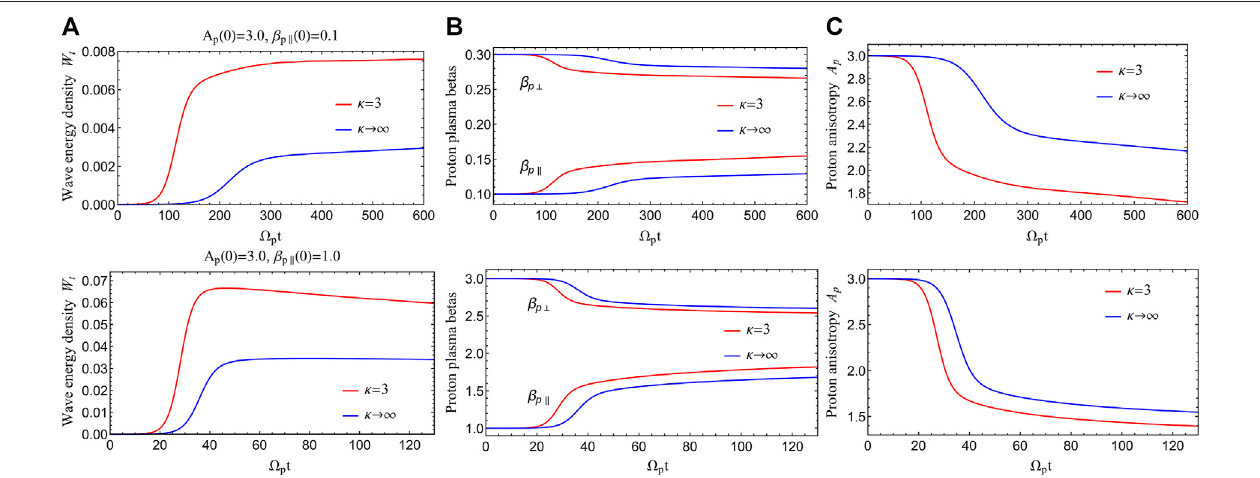
FIGURE6| QLevolutionoftheEMICinstabilityforbi-Kappa (red) and bi-Maxwellianprotons: magnetic energy (A) ,componentsofprotonplasmabeta (B) and the subsequent relaxation of the anisotropy (C) , obtained for A p ( t (cid:1) 0) (cid:1) 3.0 and β p (cid:3) ( t (cid:1) 0) (cid:1) 0.1 (top) and β p (cid:3) ( t (cid:1) 0) (cid:1) 1.0 (bottom) .